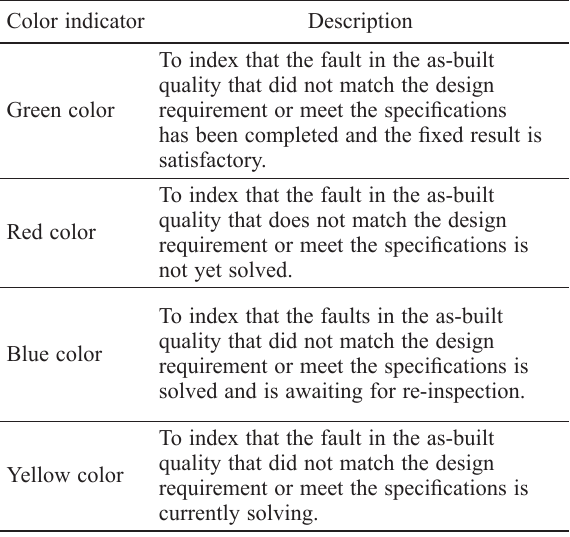
Table 2. The application of color usage in BIMDM system Color indicator